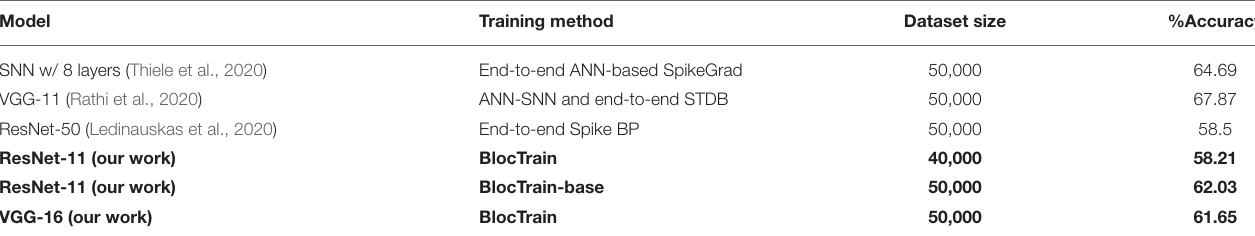
TABLE 2 | Accuracy of spiking neural network (SNN) trained using BlocTrain and end-to-end spike-based backpropagation through time (BPTT) methods on the CIFAR-100 dataset.